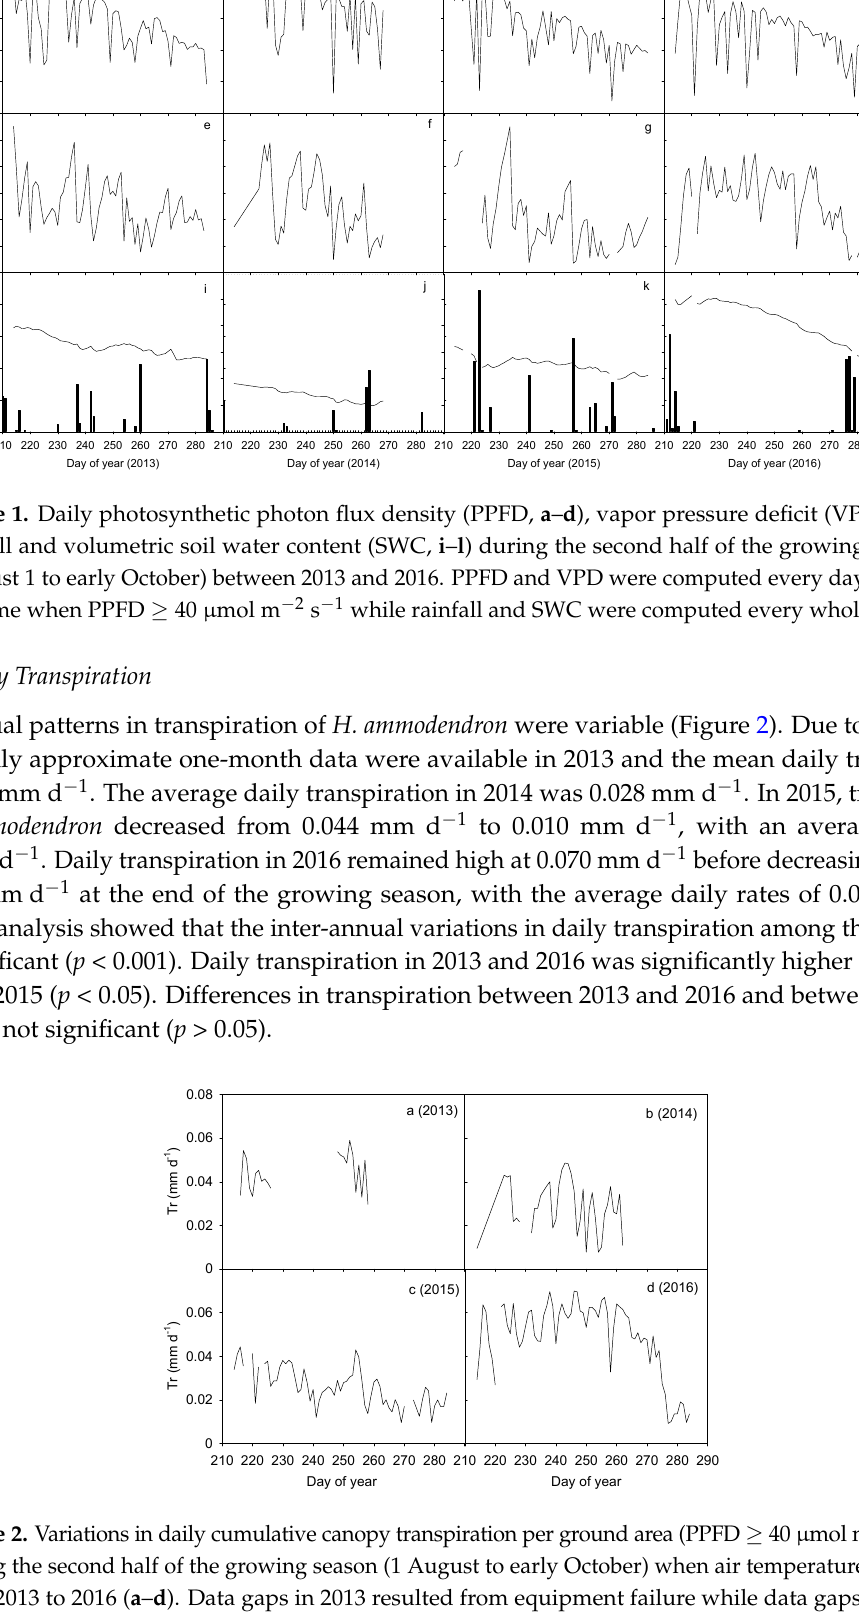
Figure 2. Variations in daily cumulative canopy transpiration per ground area (PPFD ≥ 40 μ mol m − 2 s − 1 ) during the second half of the growing season (1 August to early October) when air temperature >10 °C from 2013 to 2016 ( a – d ). Data gaps in 2013 resulted from equipment failure while data gaps in 2014 were due to low air temperatures (<10 °C) at the end of the measurement period.